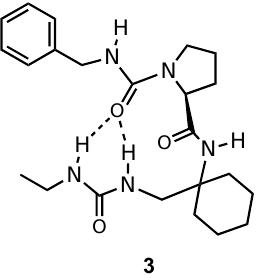
Figure 2. Our β -turn-inducing structures candidate.